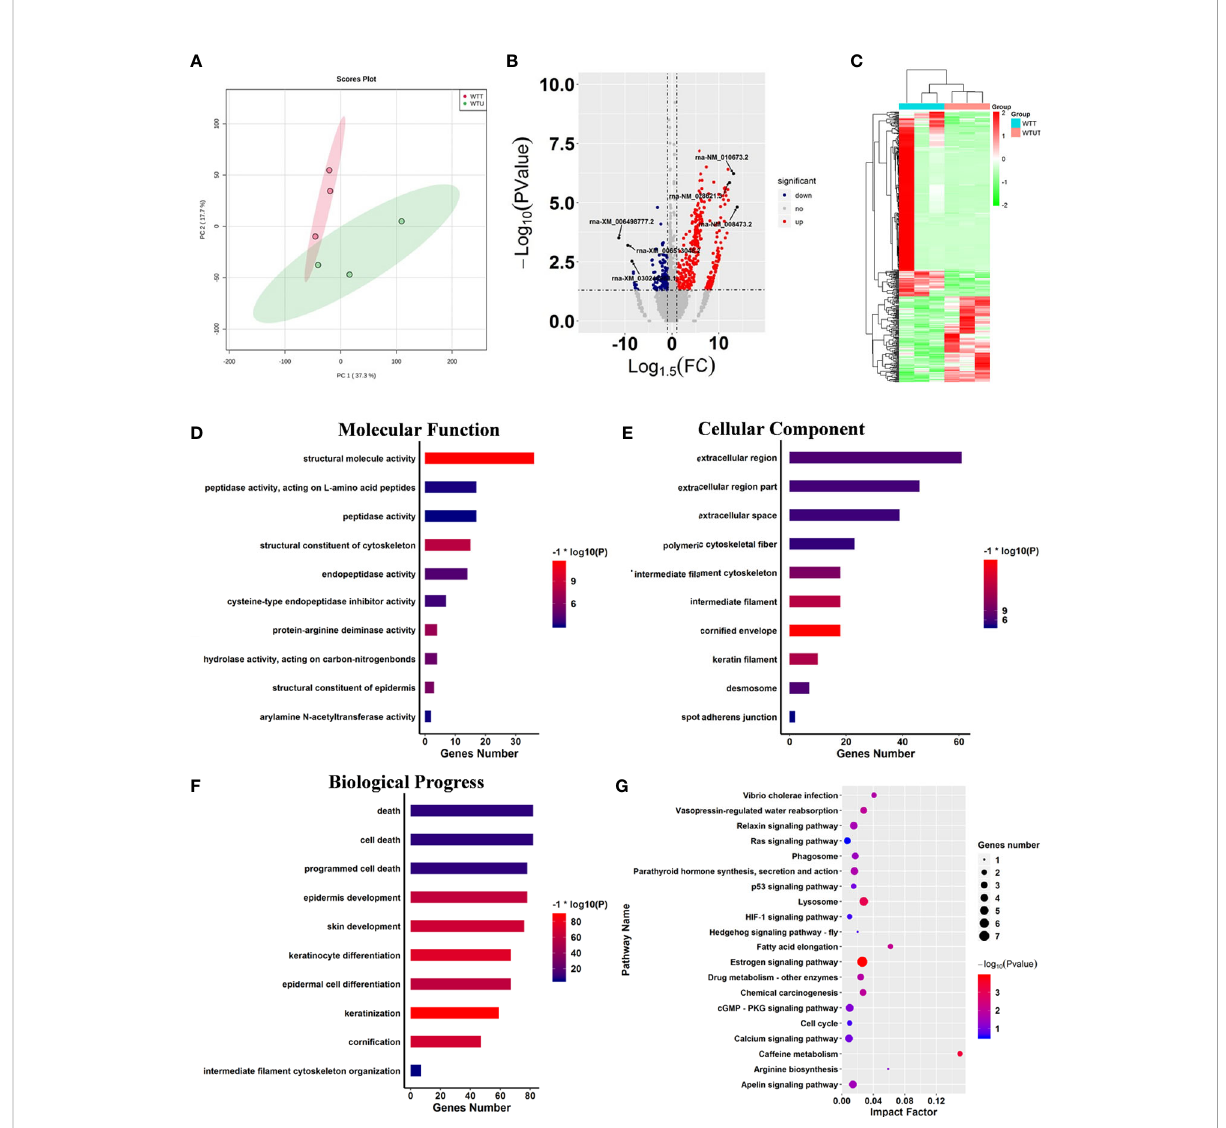
FIGURE 2 Harmine affected cancer-related progress. (A) Principle component analysis displaying the observable variation in the gene expression pattern under harmine treatment. The points in the red region represent the harmine-treated samples, whereas the points in the green region represent the control samples. (B) Volcano plot of the differentially expressed genes in response to harmine treatment. The down- and upregulated genes are shown in blue and red, respectively (log2fold change < -1 or > 1; P < 0.05). (C) Heatmap showing two different gene expression patterns under harmine treatment. The up-and downregulated genes are shown in red and green. Each column represented a sample in the GEO dataset. (D-F) Gene ontology enrichment analysis of the differentially expressed genes; (D) molecular function; (E) cellular component; (F) biological progress; (G) Kyoto Encyclopedia of Genes and Genomes pathway analysis of the differentially expressed genes. The size of the circle indicates the number of genes involved in the pathway, whereas the circle color represents the signi fi cance of enriched pathways ( P <